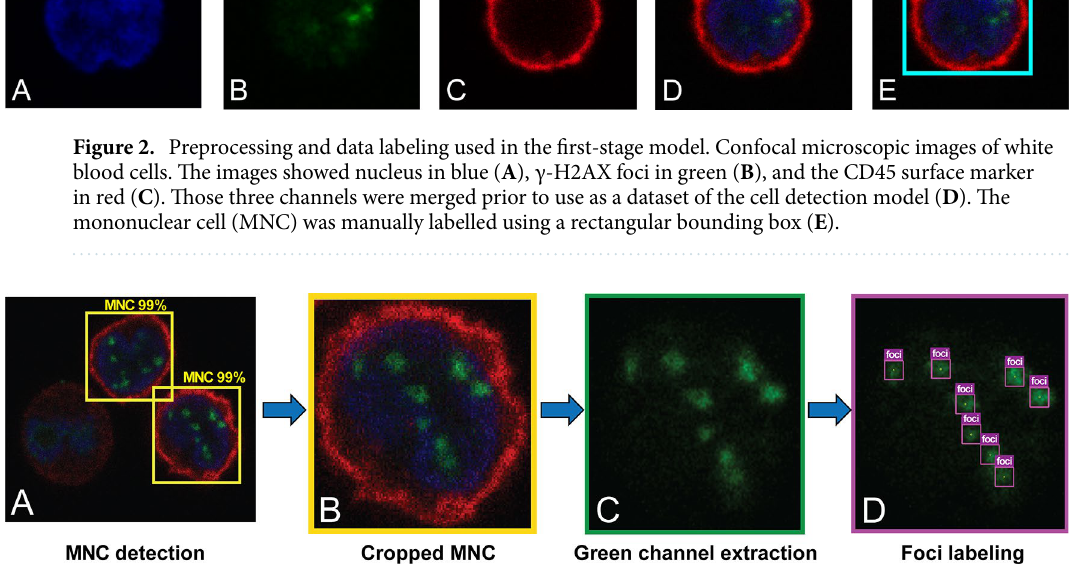
Figure 3. Cell detection, cell cropping, preprocessing data (green channel extraction) and foci annotation process. Mononuclear cell (MNC) detection in a three-channel z-stack image with detection confidence ( A ), a cropped cell ( B ), green channel extraction (γ-H2AX foci) ( C ), and foci labeling ( D